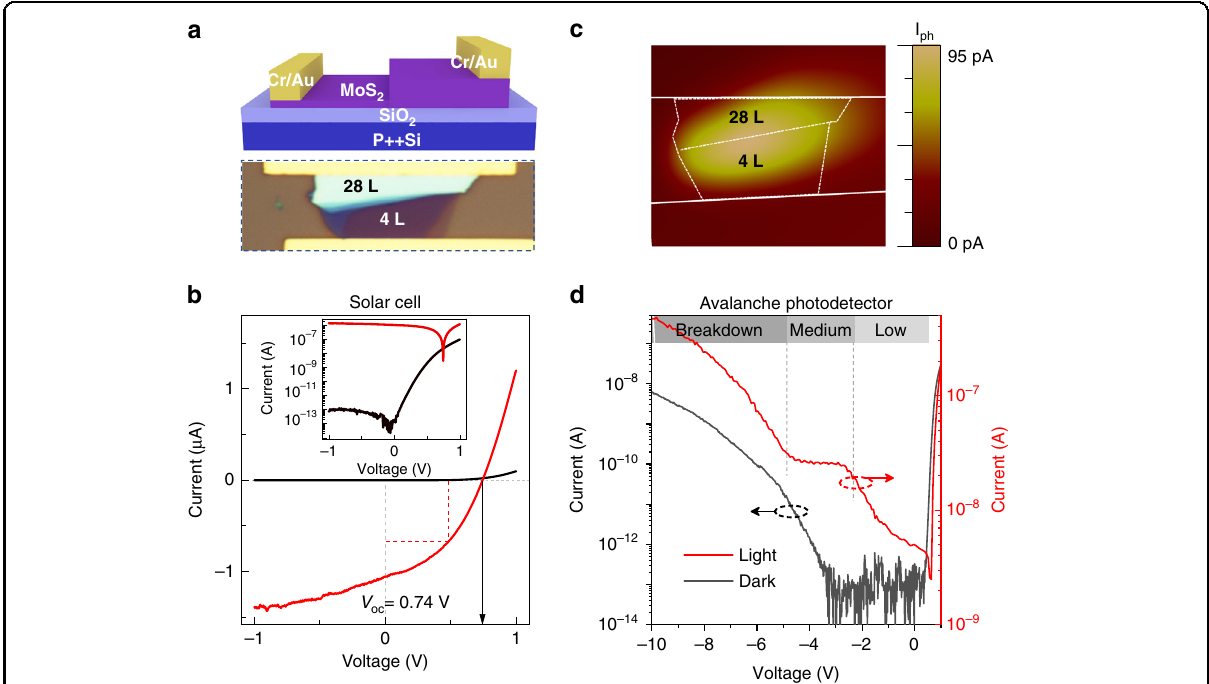
Fig. 3 Layer PN junction and diode device based on it. a Schematic and optical-microscope images of a layer PN junction on MoS 2 fl ake. In such device, it simply requires a MoS 2 fl ake to consists of two-stepwise layer thickness, 4L and 28L. Symmetrical electrodes (Cr/Au) were deposited on both sides afterwards. b Dark and photo-excited IV curves of the MoS 2 layer junction. The measurements were performed at room temperature and under an illumination of 1 µW/µm 2 @ 520 nm. Inset: IV curves in semilog-coordinate. c Scanning-photocurrent-microscopy (SPCM) image of such device. The laser-beam is 520 nm in wavelength and ~1 µm in diameter. The white dashed lines mark the boundary of metal-electrodes, 4L and 28L MoS 2 . d Low temperature (~100 K) dark and photo-excited IV curves (under an illumination of 0.42 mW/mm 2 @ 520